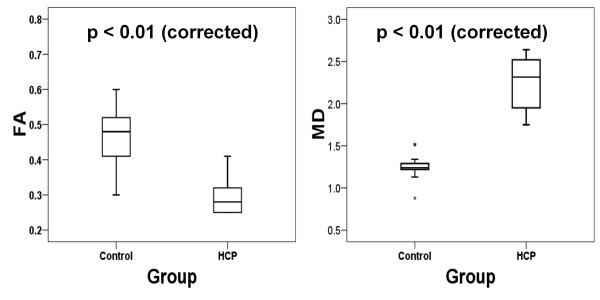
Box-plots comparing the fractional anisotropy (FA) and mean diffusivity (MD, 10-3mm2/s) values in corpus callosum in hydrocephalic rats and the control rats. All ages combined, n = 12 for hydrocephalic and n = 15 for control rats. The Wilcoxon two-sample test showed a significant difference (p < 0.05, corrected for multiple comparison).